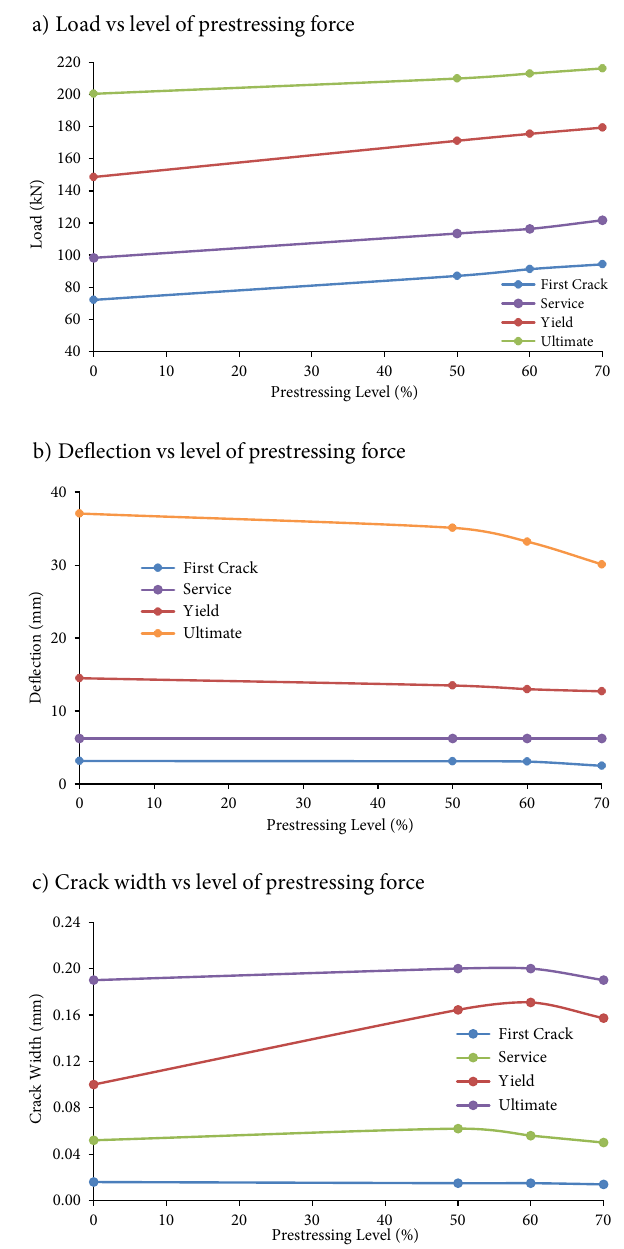
Figure 12. Effect of level of prestressing